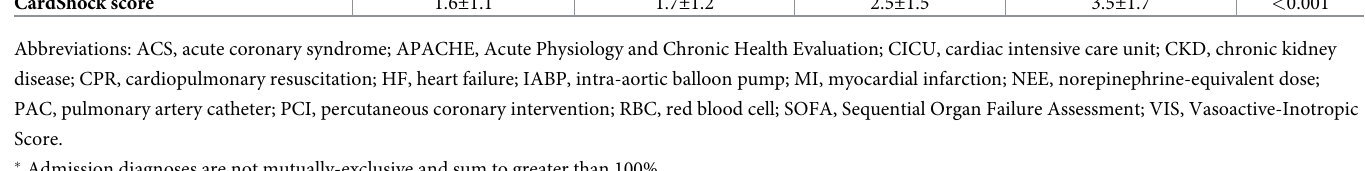
The final multivariable model had an AUC of 0.93 for discrimination of in-hospital mortality ( Table 5 ). After adjustment, ECHO-LVSWI remained strongly and inversely associated